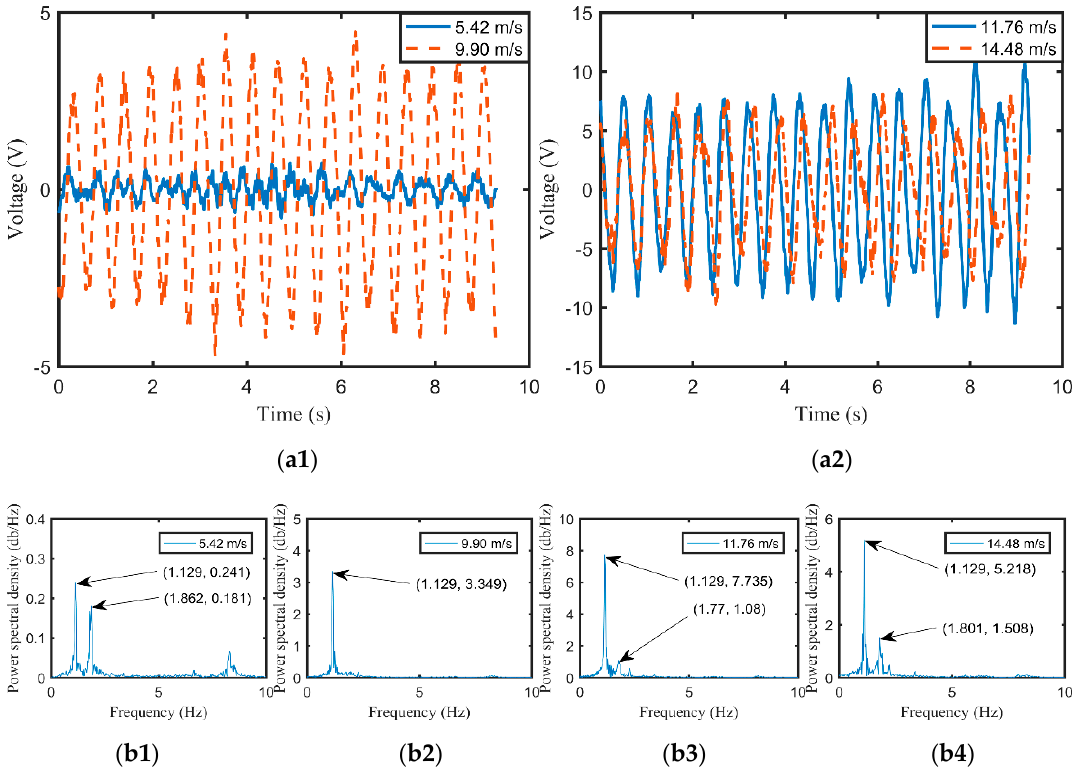
Figure 5. Time history and power spectral density of output voltage for CBEH-130-30 at 5.42, 9.90, 11.76, and 14.48 m/s: ( a ) time history; and ( b ) power spectral density.